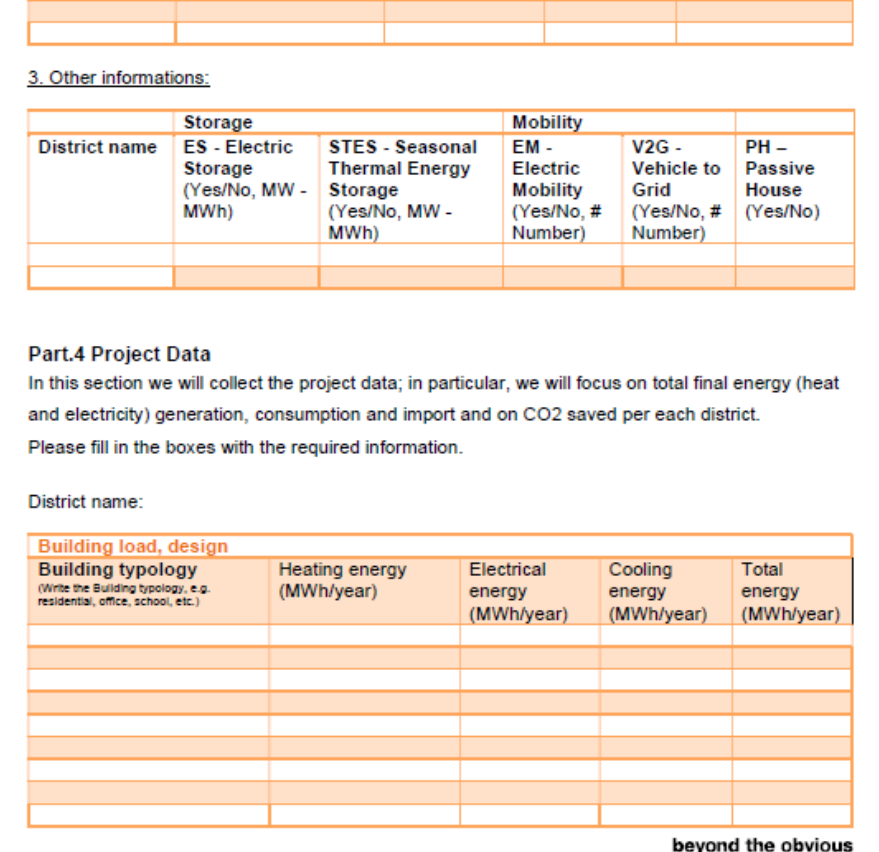
Figure A3. Copy of the third page of the questionnaire produced to conduct this study.